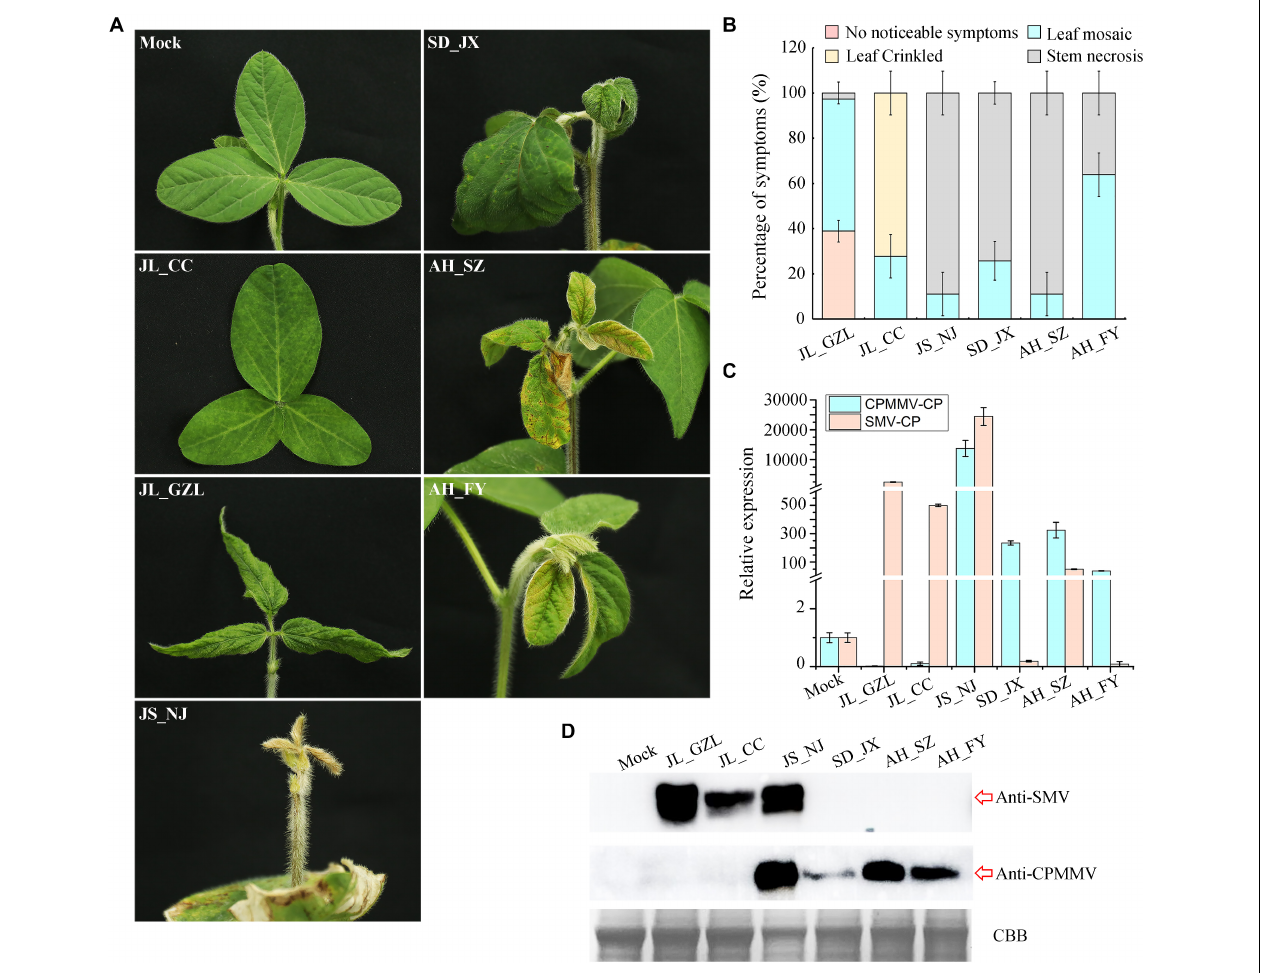
FIGURE 5 | Symptoms of SMV/CPMMV infection on soybean. (A) Photographs of soybean (Jiunong 9) pants 10 days after inoculation with sap from different field locations. (B) The percentages of SMV/CPMMV-infected plants with different grades of disease symptoms, n = 12. (C) SMV and CPMMV RNAs in infected plants as determined by RT-qPCR. Data are shown as means ± SD of three biological replicates. (D) SMV and CPMMV coat protein (CP) protein levels in mock-inoculated and SMV/CPMMV-infected plants as determined by immunoblot analysis. Coomassie brilliant blue (CBB) staining of the same extracts is shown to demonstrate equal